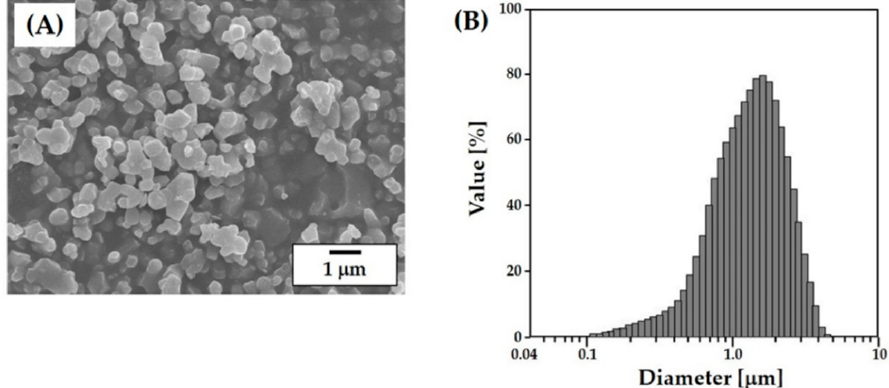
Figure 2. ( A ) Representative SEM image of the as-received CaP powders and ( B ) the particle size distribution of the as-received CaP powders.